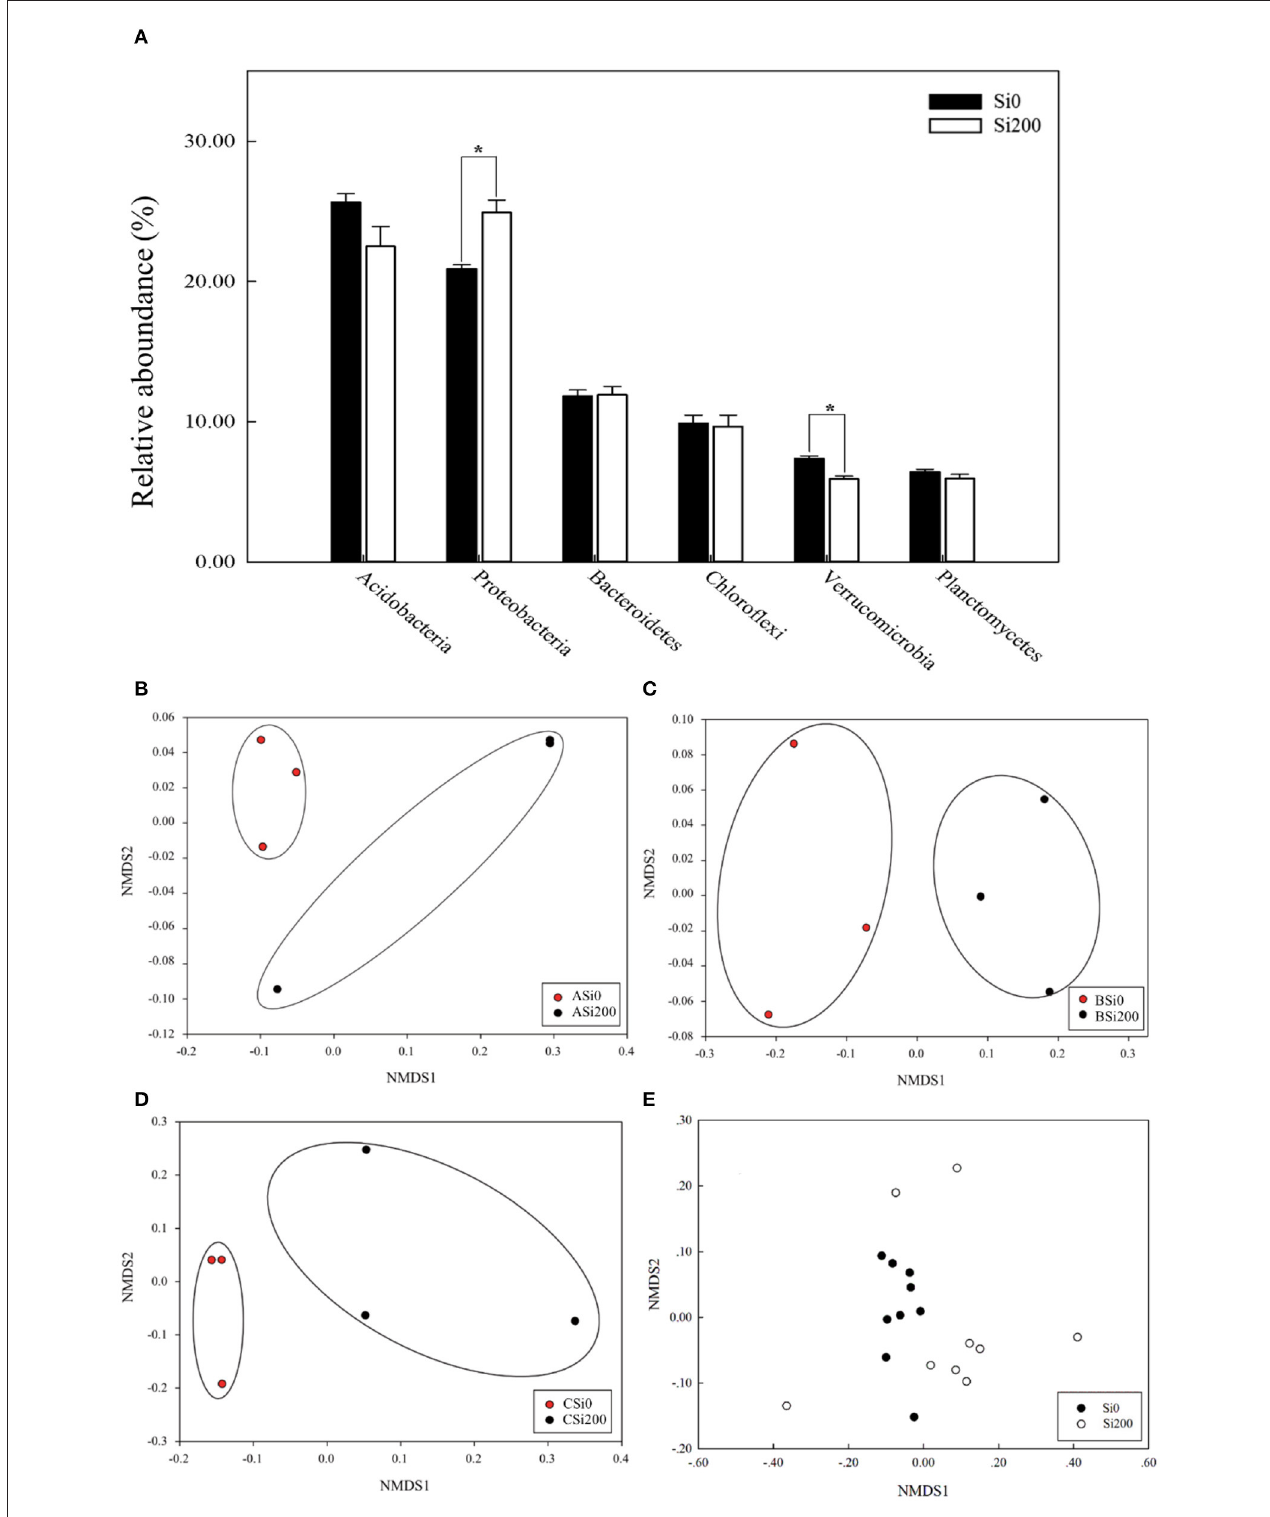
FIGURE 3 | The relative abundances of the five most enriched bacterial phyla in the three sugarcane varieties under the two silicon (Si) treatments (A) . Non-metric multidimensional scaling (NMDS) based on the Bray–Curtis dissimilarity matrix in the two Si treatments of VA (B) , VB (C) , VC (D) , and all soil samples (E) . *,Significant at the 0.05 probability